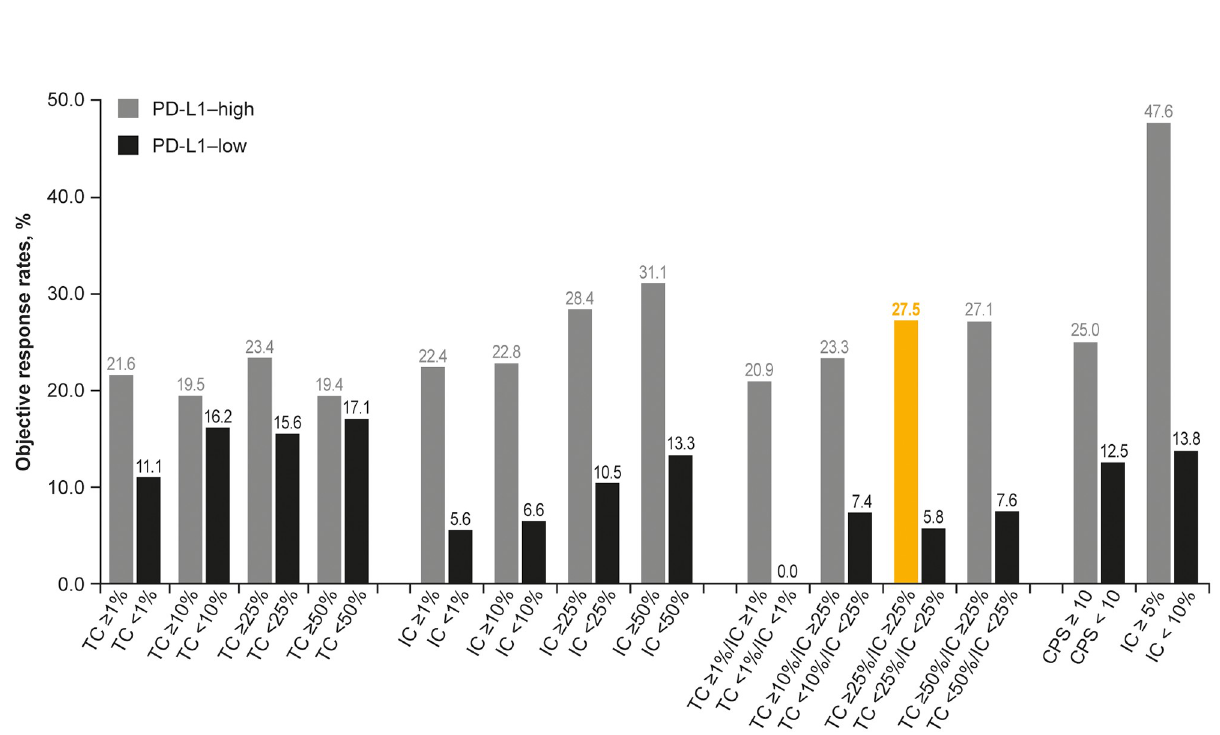
Fig 6. Objective response rates in study 1108 at different TC and IC cutoffs for defining positive (PD-L1–high) and negative (PD-L1–low) expression. IC, tumor-infiltrating immune cells; PD-L1, programmed death ligand-1; TC, tumor cells. Highlighted bar indicates the PD-L1 cutoff previously used to investigate response to